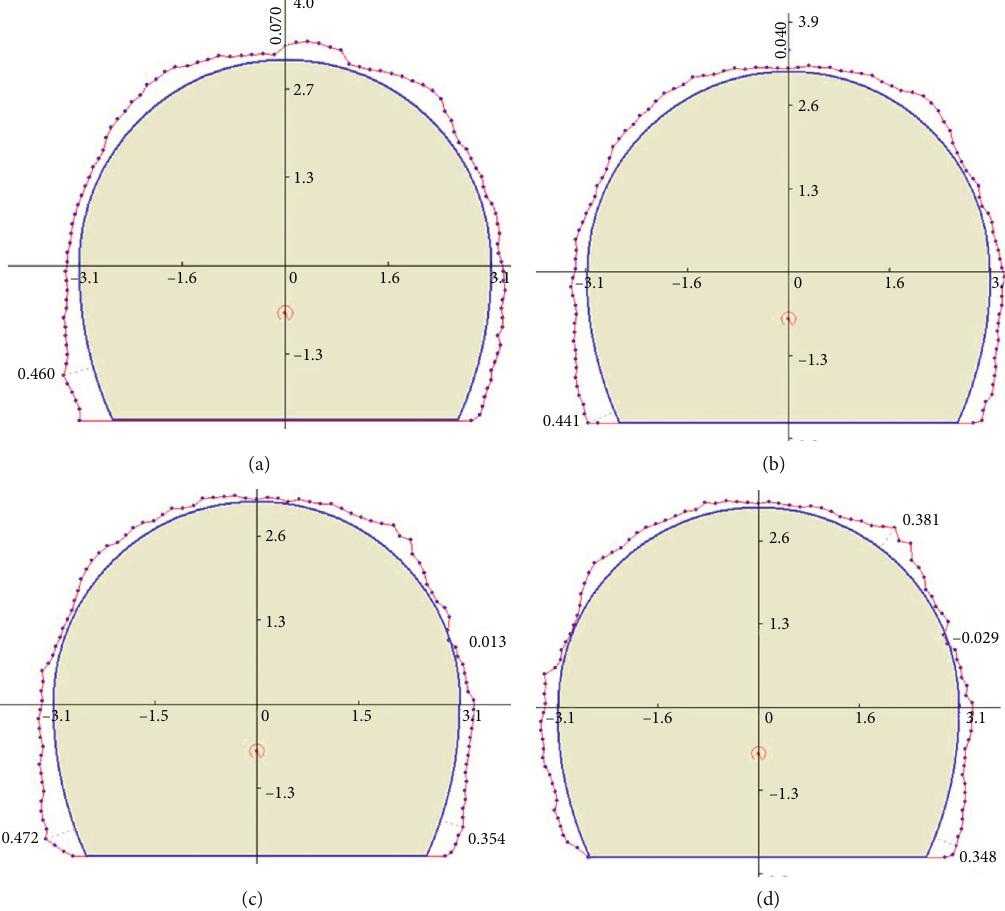
Figure 12: E ff ect of the SSK0 + 715 smooth blasting cycle for (a) surface no. 1, (b) surface no. 2, (c) surface no. 3, and (d) surface no. 4.